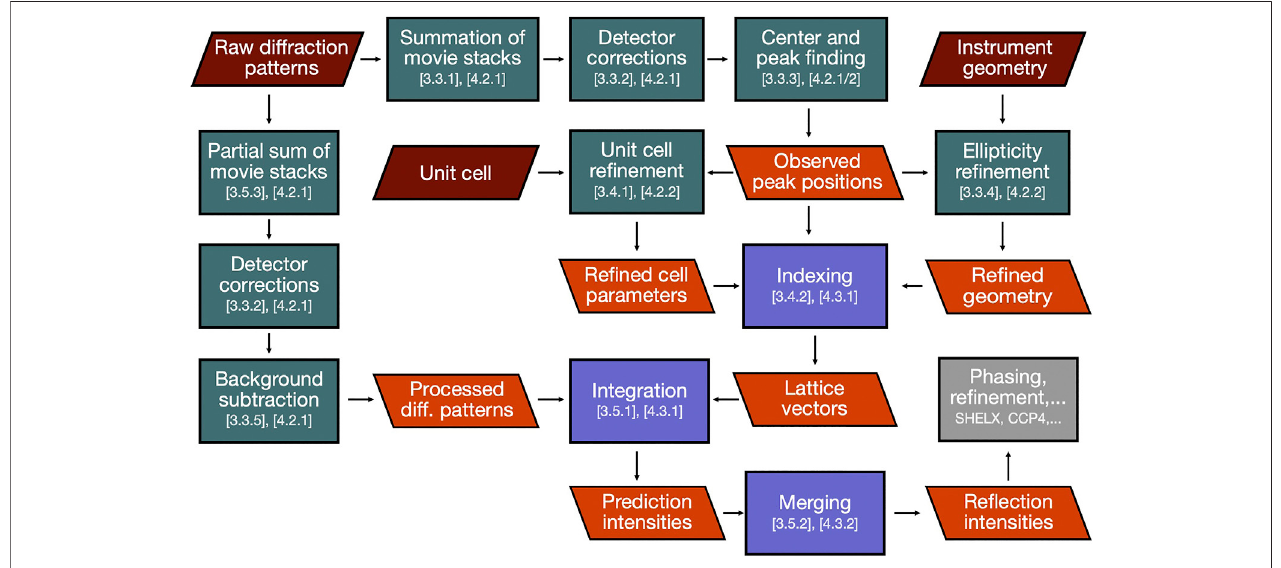
FIGURE2| JourneyofSerialEDdatathroughourdatareductionpipeline.Greenandblueboxesrepresentprocessingstepsconductedin diffractem and CrystFEL , respectively, section numbers in this paper relating to each step are indicated. Red and orange parallelograms represent input data and important intermediate results, respectively. The fi nal result (re fl ection intensities) is then handed over to structure solution software (gray